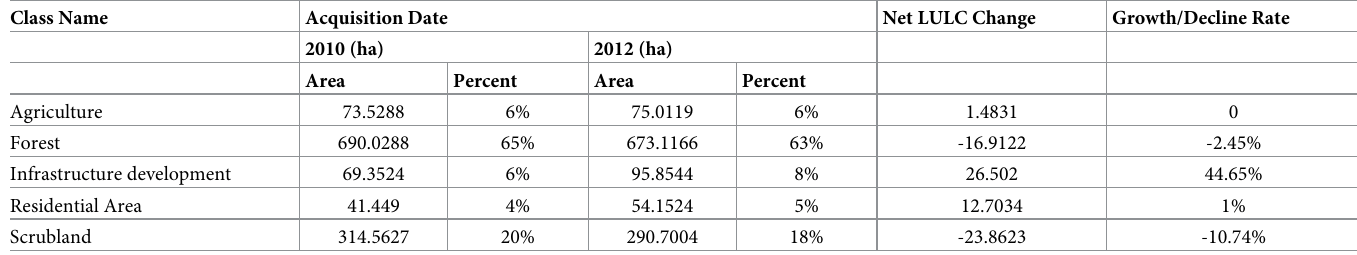
Table 7. Area (in hectares) and spatial change in land cover land use classes and overall net gain and losses between 2010 and 2012 in the study